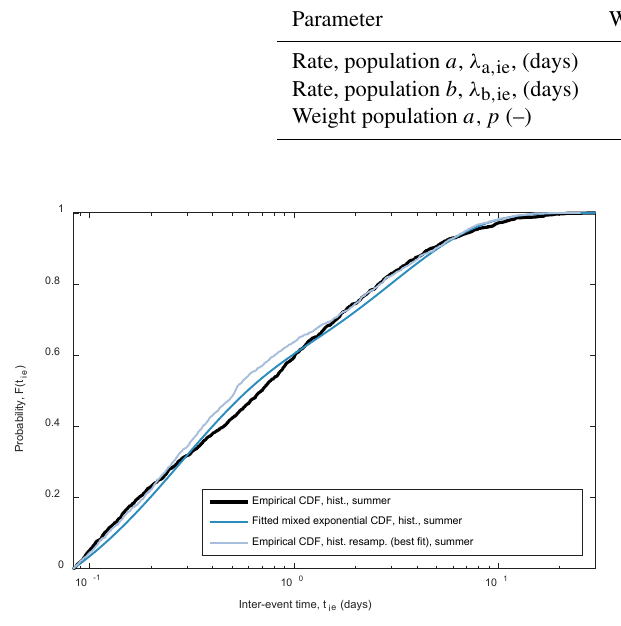
Figure 3. Example of cumulative distribution functions for summer inter-event